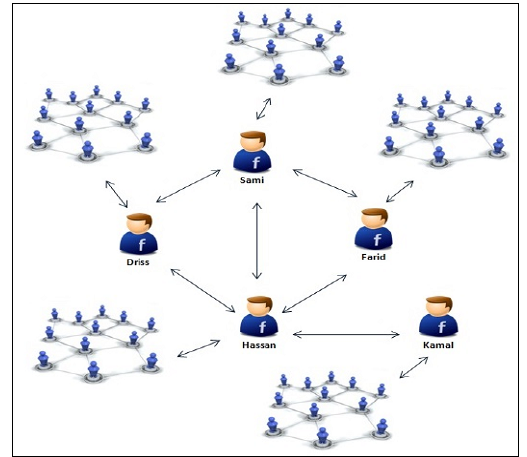
Case 3: Sharing a publication as "link" type. As